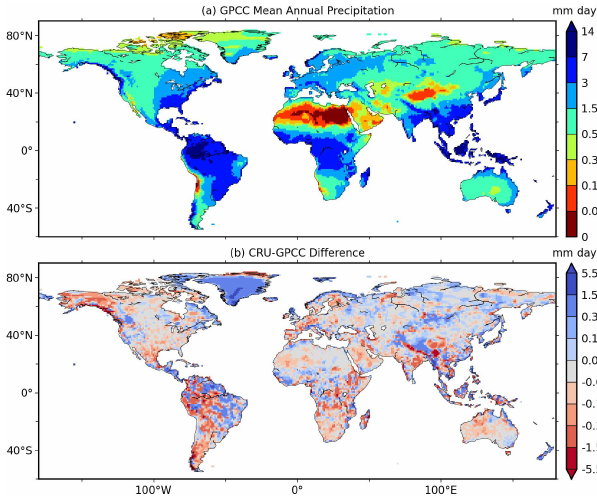
Fig. 10. (a) The GPCC mean annual precipitation and (b) the dif- ference between the CRU and GPCC mean annual